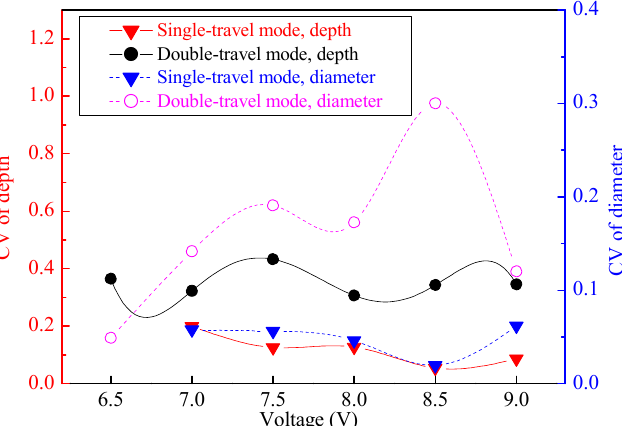
Figure 10. Change in dimensions of the arrayed micro-dimples machined in the single- / double-travel mode and with the magnetic field (single-travel time of 0.3 s and double-travel time of 0.3 × 2 s).